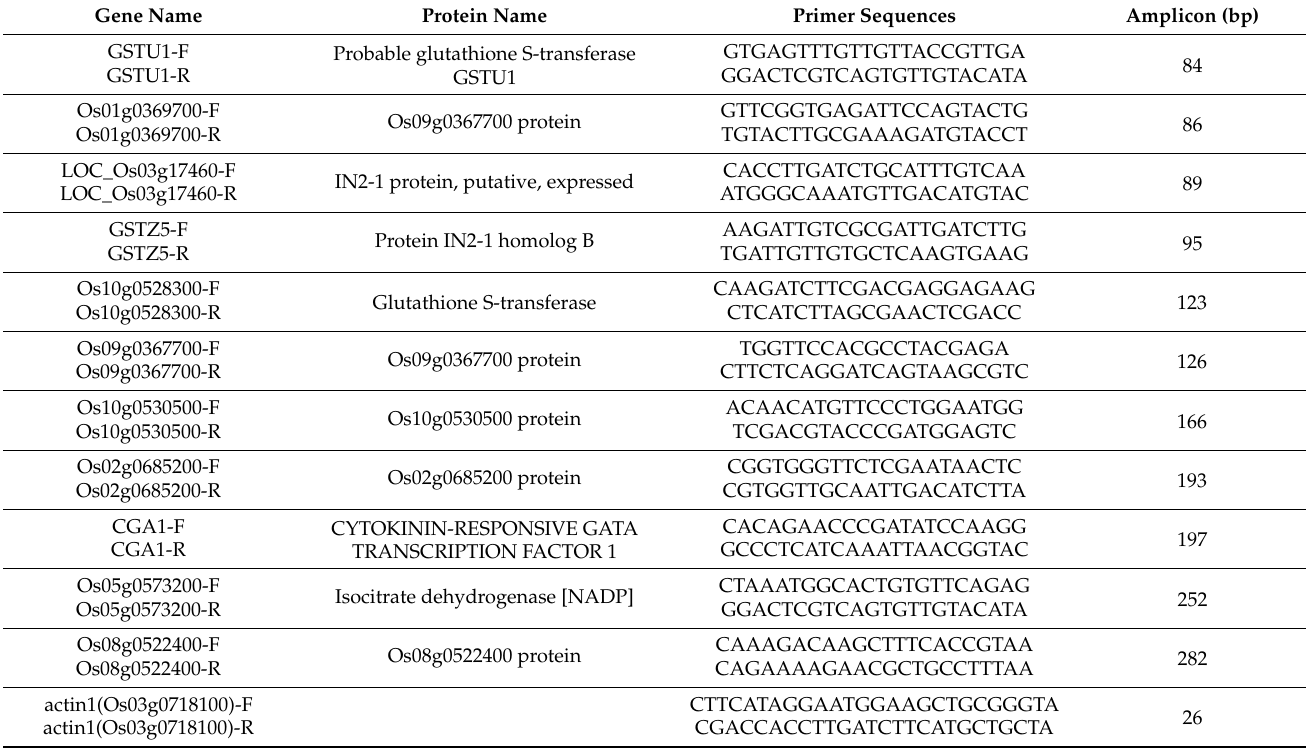
Table 1. All gene primers were used for